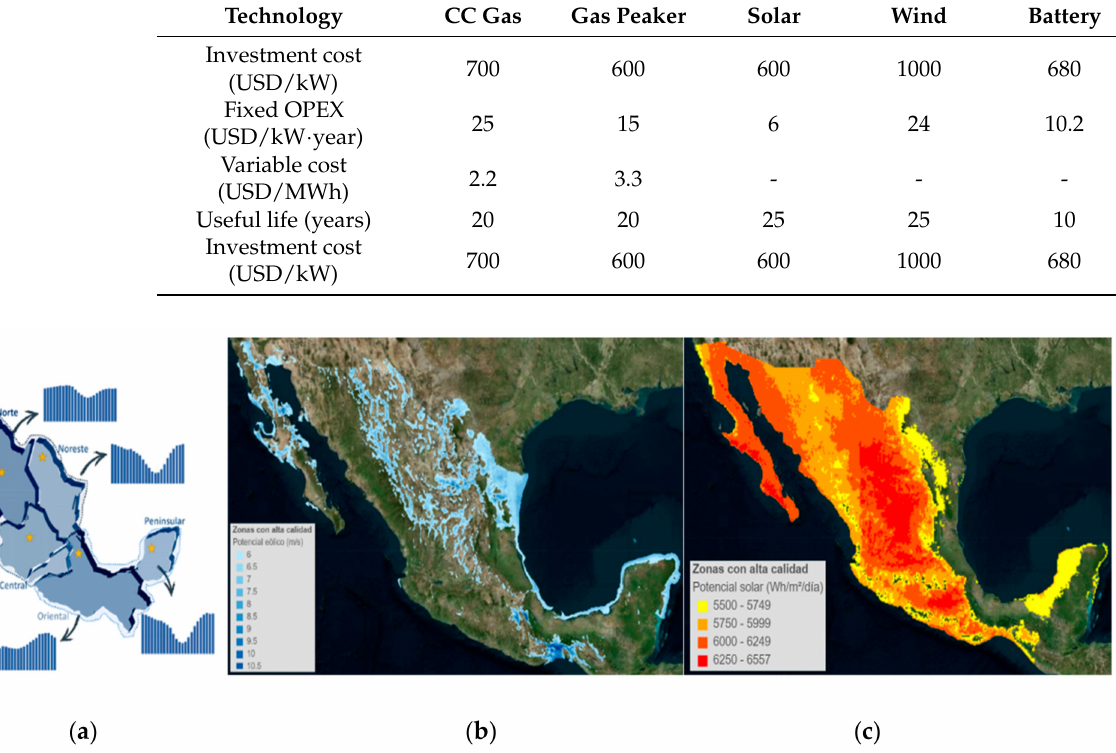
Figure 2. Wind profiles ( a ) and zones with high wind ( b ) and solar ( c ) potential in Mexico.